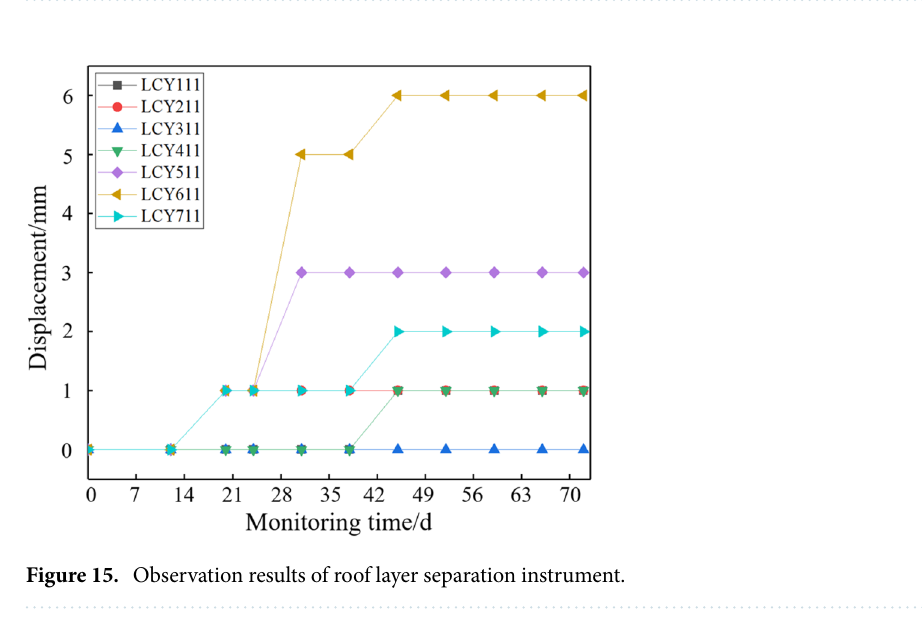
Figure 14. Top coal integrity on 12,203 open-off cut.